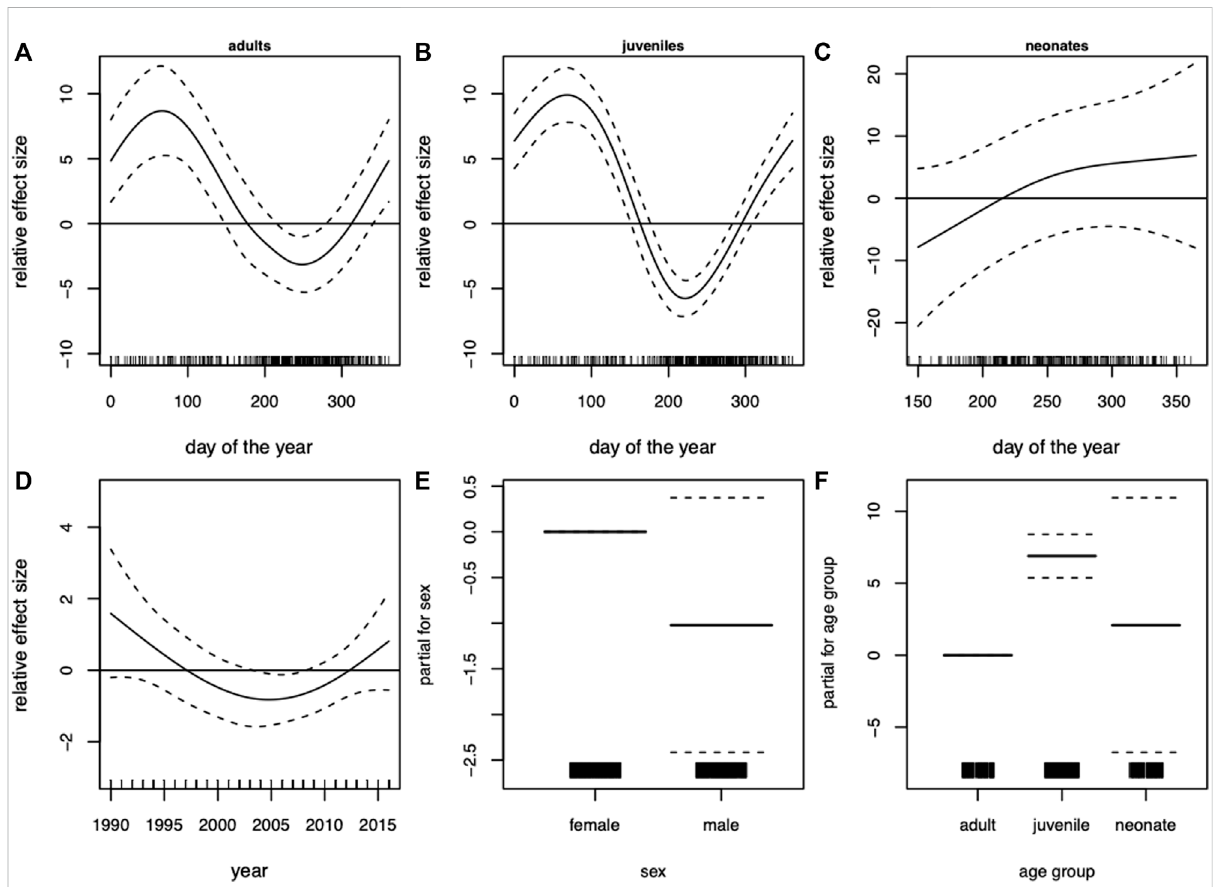
FIGURE 4 Harborporpoise( Phocoena ).Generalizedadditivemodel(GAM)ofblubberthicknessshowingtheseasonaldependency(dayoftheyear1 – 365) conditionalonagegroup (A) adults, (B) juveniles, (C) neonatesand (D) thedevelopmentovertheyears.Moreover,theparametrictermsof (E) sexand (F) age group. The y -axes represent the term ’ s spline function (solid line). Zero on the y -axes corresponds to no effect of the predictor variable. The dotted lines re fl ect two times theSE bands(i.e., 95% con fi dence interval). Hatch marks on the x -axes show sample values and ranges. Deviance explained = 47.2%, n =